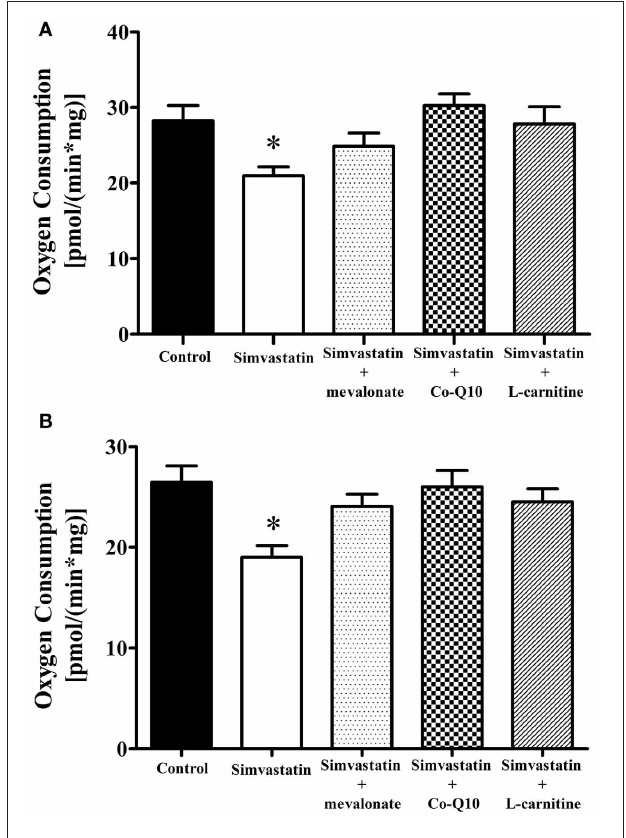
FIGURE 3 | Inhibition by 1 µ M simvastatin of (A) ADP or (B) FCCP-stimulated oxygen consumption supported by complex I substrates was prevented by mevalonate, Co-Q10 or L-carnitine. Skeletal muscle samples were incubated in MiR05 medium in the presence figures. ∗ p < 0 . 05 vs control by one-way analysis of variance. N = at least 6 independent